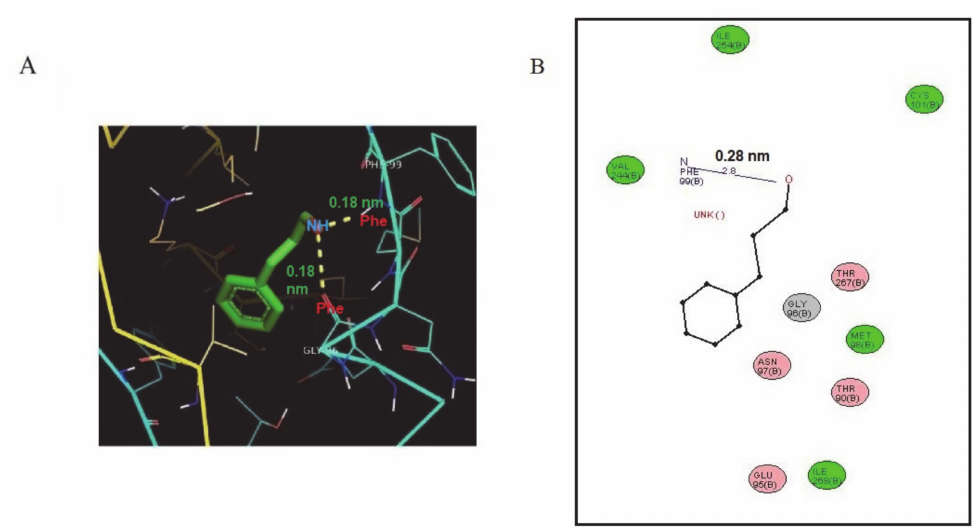
Figure 2. Results of the docking analysis of K. pneumoniae HDC protein with cinnamaldehyde (CA). ( A ) Residues of K. pneumoniae histidine decarboxylase docking showing amino acid interactions with CA. ( B ) In silico analysis of ligand binding with the protein structure of HDC as well as amino acid interactions at the atomic level of hydrogen with residues and with the measurement of distance between interacting molecules, as shown in ( A ) and ( B